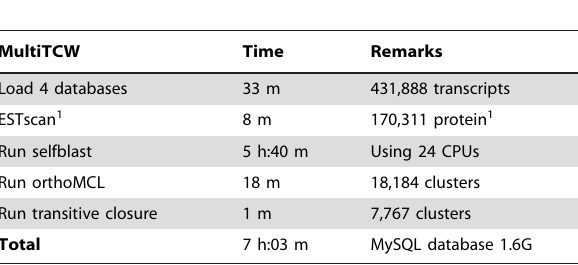
Table 2. Timing results for building a multiTCW database from 4 singleTCW